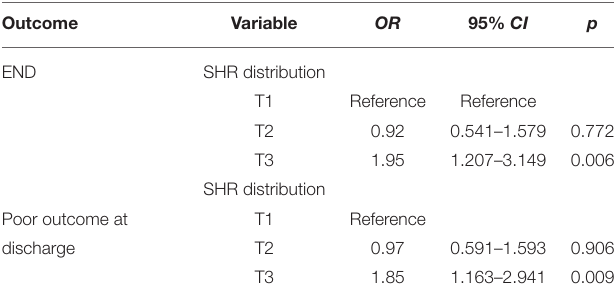
TABLE 3 | Multivariate logistical regression analyses depicting the association of SHR and respective